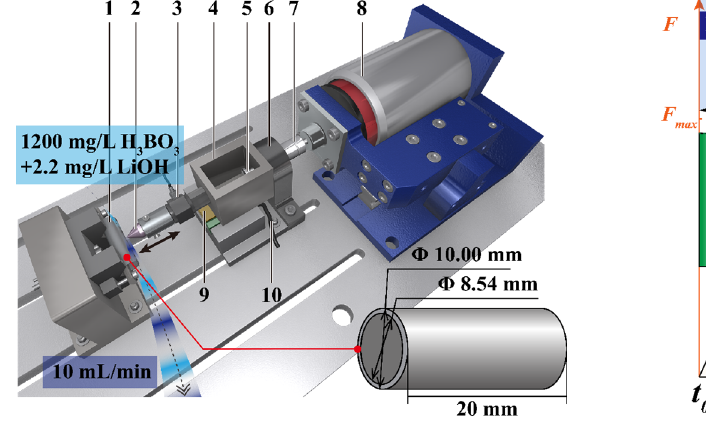
Table 2. Experimental parameters for the impact wear test.